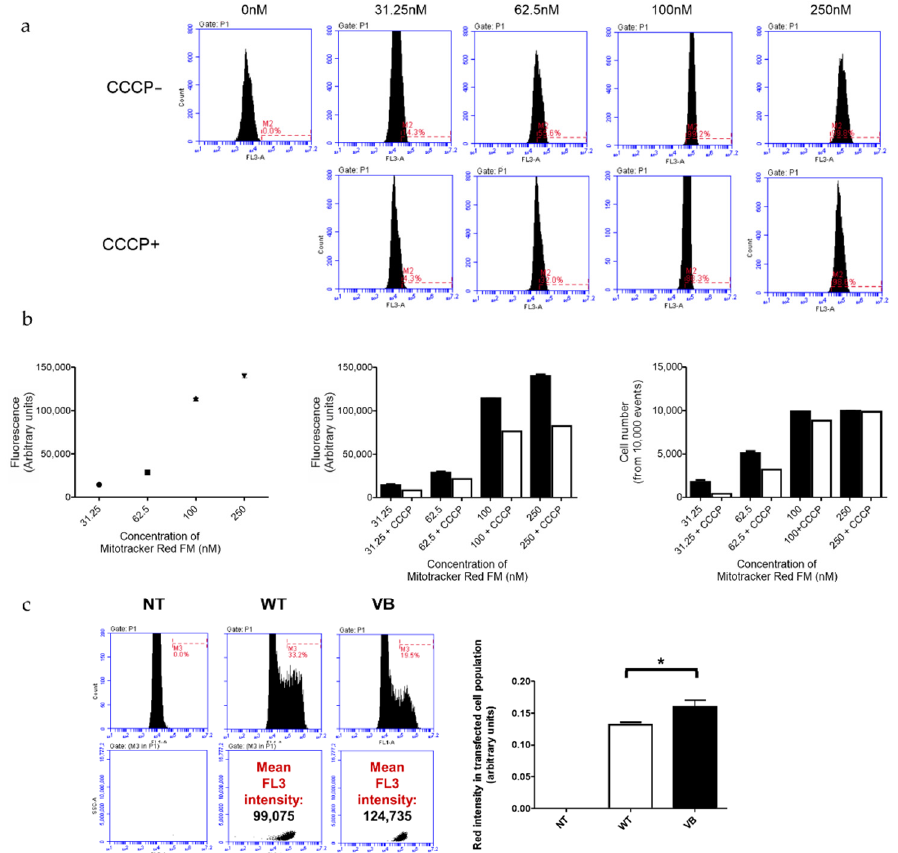
Figure 5. Analysis of mitochondrial membrane potential ( ∆ ψ m) in ARPE-19 cells transfected with WT and variant B (VB) cystatin C EGFP fusion constructs. ( a ) Evaluation of optimal Mitotracker Red FM concentration required to stain the entire ARPE-19 cell population (+/ − CCCP, an uncoupling agent that disrupts oxidative phosphorylation). Concentrations used for optimization ranged between 0–250 nM. Flow cytometry utilizing the FL3 channel was used for analysis. ( b ) Graphs show FL3 fluorescence intensity for cells stained with different concentrations of Mitotracker Red FM (left = optimization line graph; middle = +/ − CCCP optimization bar graph; and right = number of cells stained with the concentration range of Mitotracker Red FM +/ − CCCP). ( c ) Flow cytometry analysis of ARPE-19 cells transfected with EGFP WT or variant B cystatin and stained with Mitotracker Red FM. After P1 gating was performed to exclude dead cells and debris (not shown), M1 (green channel) histograms were used to measure transfection efficiency (left). The M1 population was then selected to measure red intensity (FL3), as shown by middle and right plots. Graph shows red fluorescence intensity (FL3 channel) in the transfected (green; FL1 channel) cell population (arbitrary units ± S.E.M. minimum of n = 3; Student’s t test * p ≤ 0.05 ) .